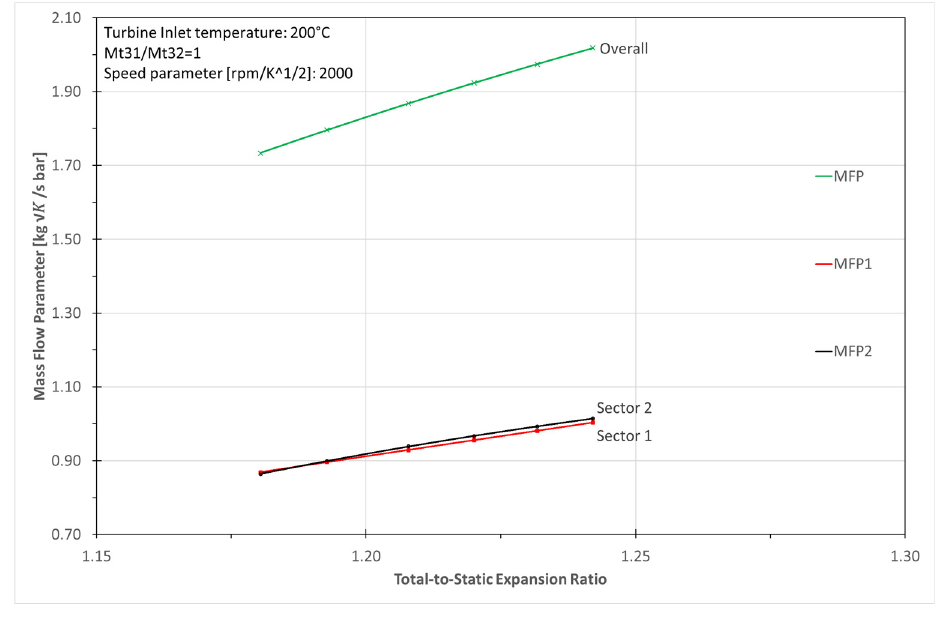
Figure 6. Comparison between MFP, MFP1, and MFP2 for Mt31/Mt32 = 1 at (cid:1840) (cid:3047) = 2000 (cid:4674) (cid:2928)(cid:2926)(cid:2923)